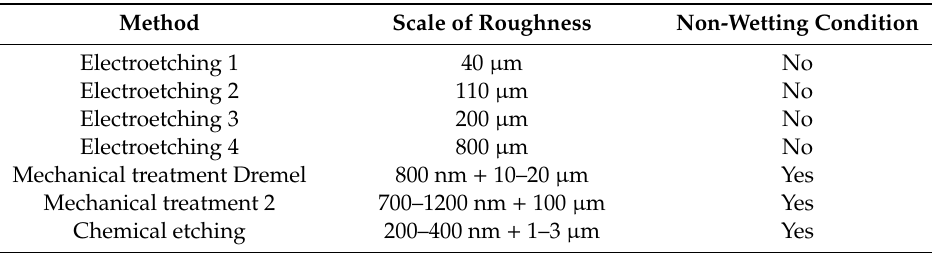
Table 1. Roughness and non-wetting condition obtained by di ff erent